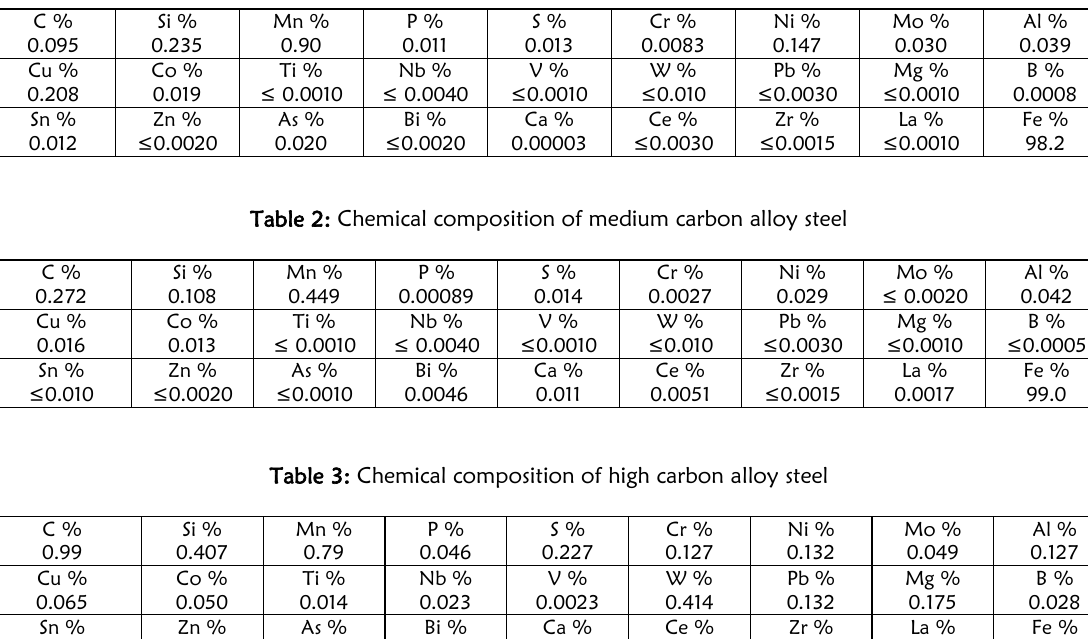
Table 1: Chemical composition of low carbon alloy steel